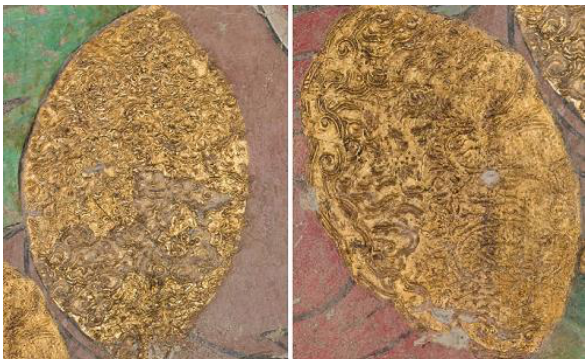
Figure 7 A04 mural image, the damaged plaster was not replaced before gilding causing it to become concave